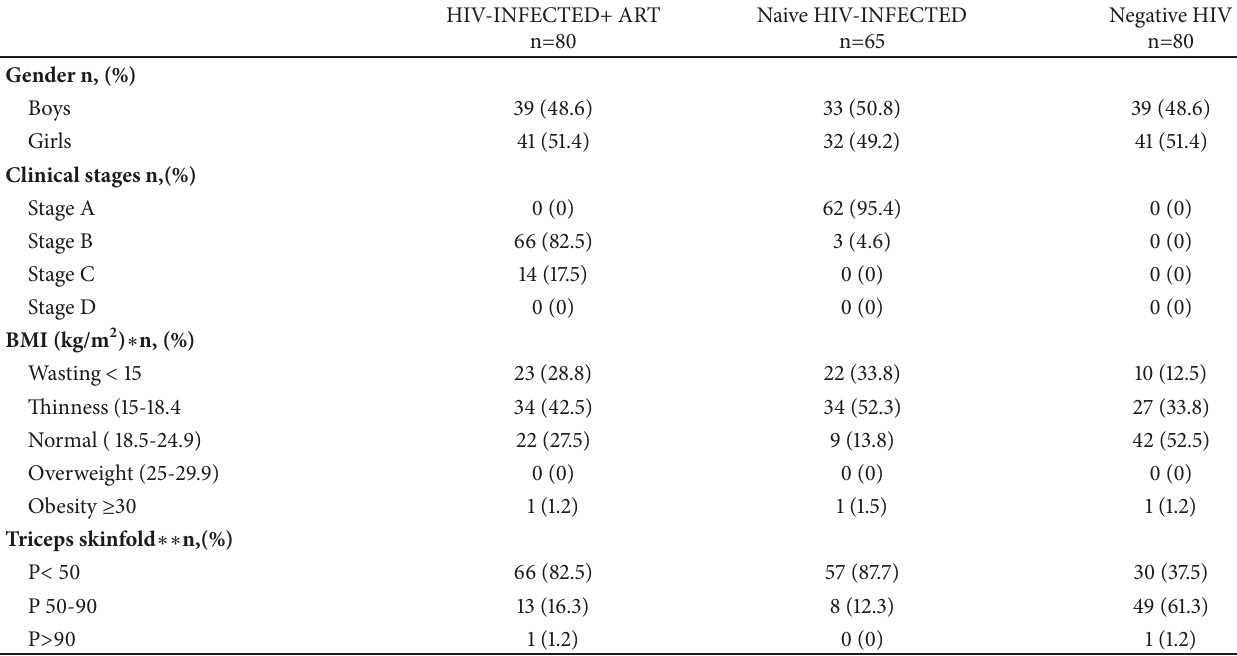
Table 1: Characteristics of the study population.